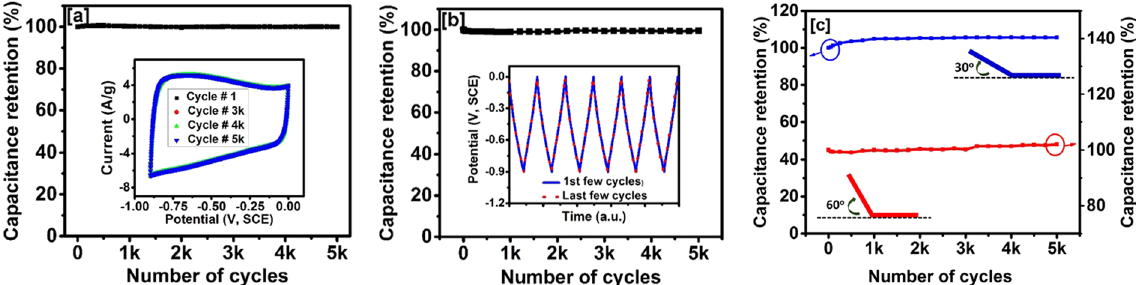
Figure 8. ( a ) Capacitance retention verse number of CV cycles, inset figure shows CV curves at various cycles ( b ) capacitance retention verse number of charge-discharge cycles, inset figure shows potential verses time plot for first and last few cycles of charge-discharge, and ( c ) capacitance retention verse number of charge-discharge cycles at various bending angles.